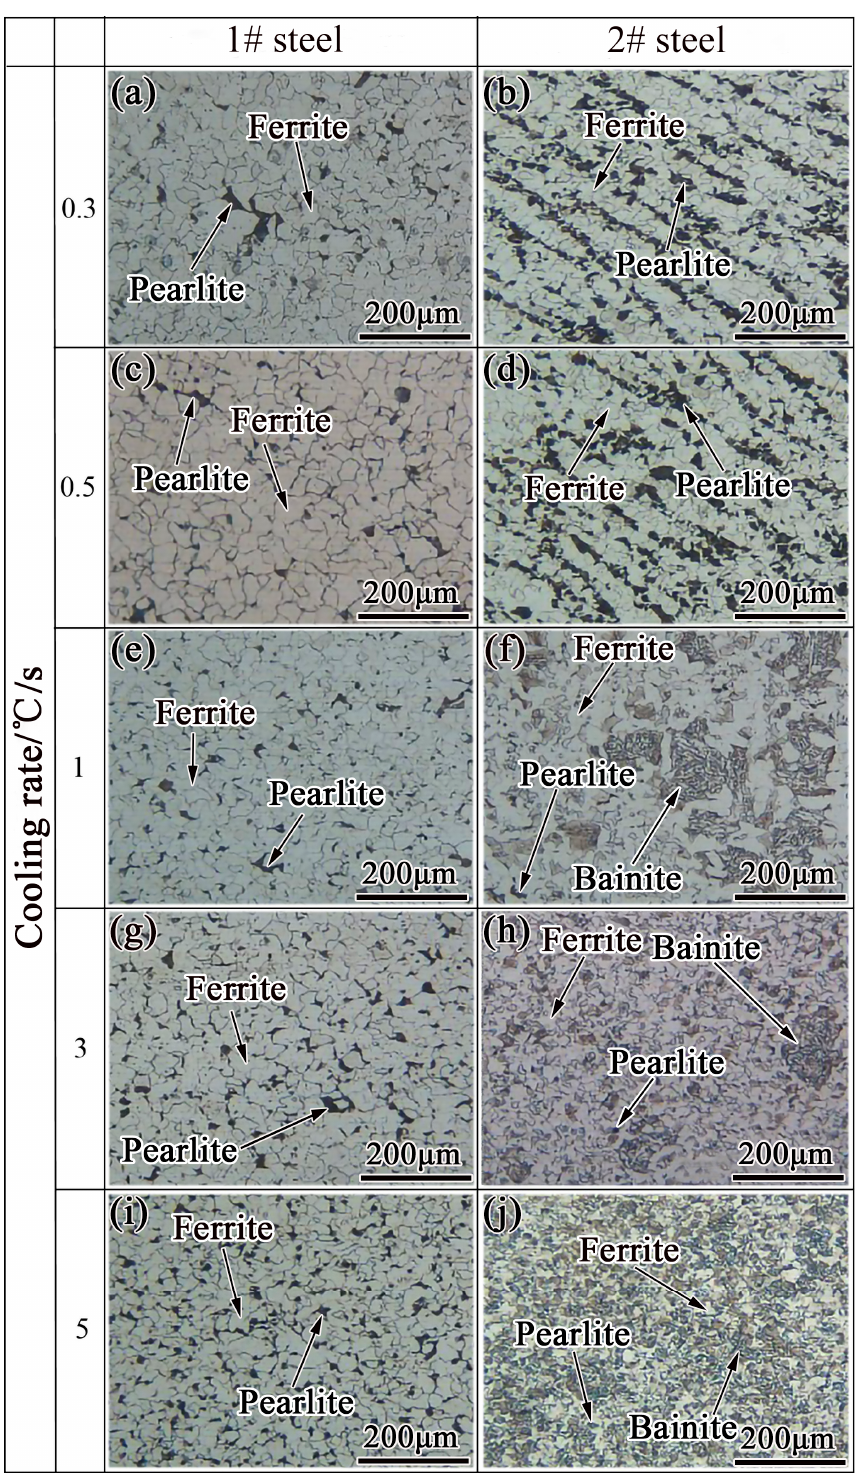
Figure 7. Microstructure transformation of ( a , c , e , g , i ) steel 1# and ( b , d , f , h , j ) steel 2# at different cooling rates.